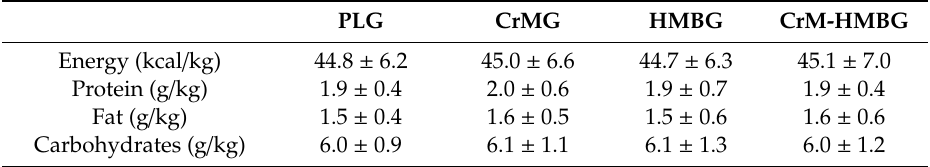
Table 1. Energy and macronutrient intake in each study group during 10 weeks of study.